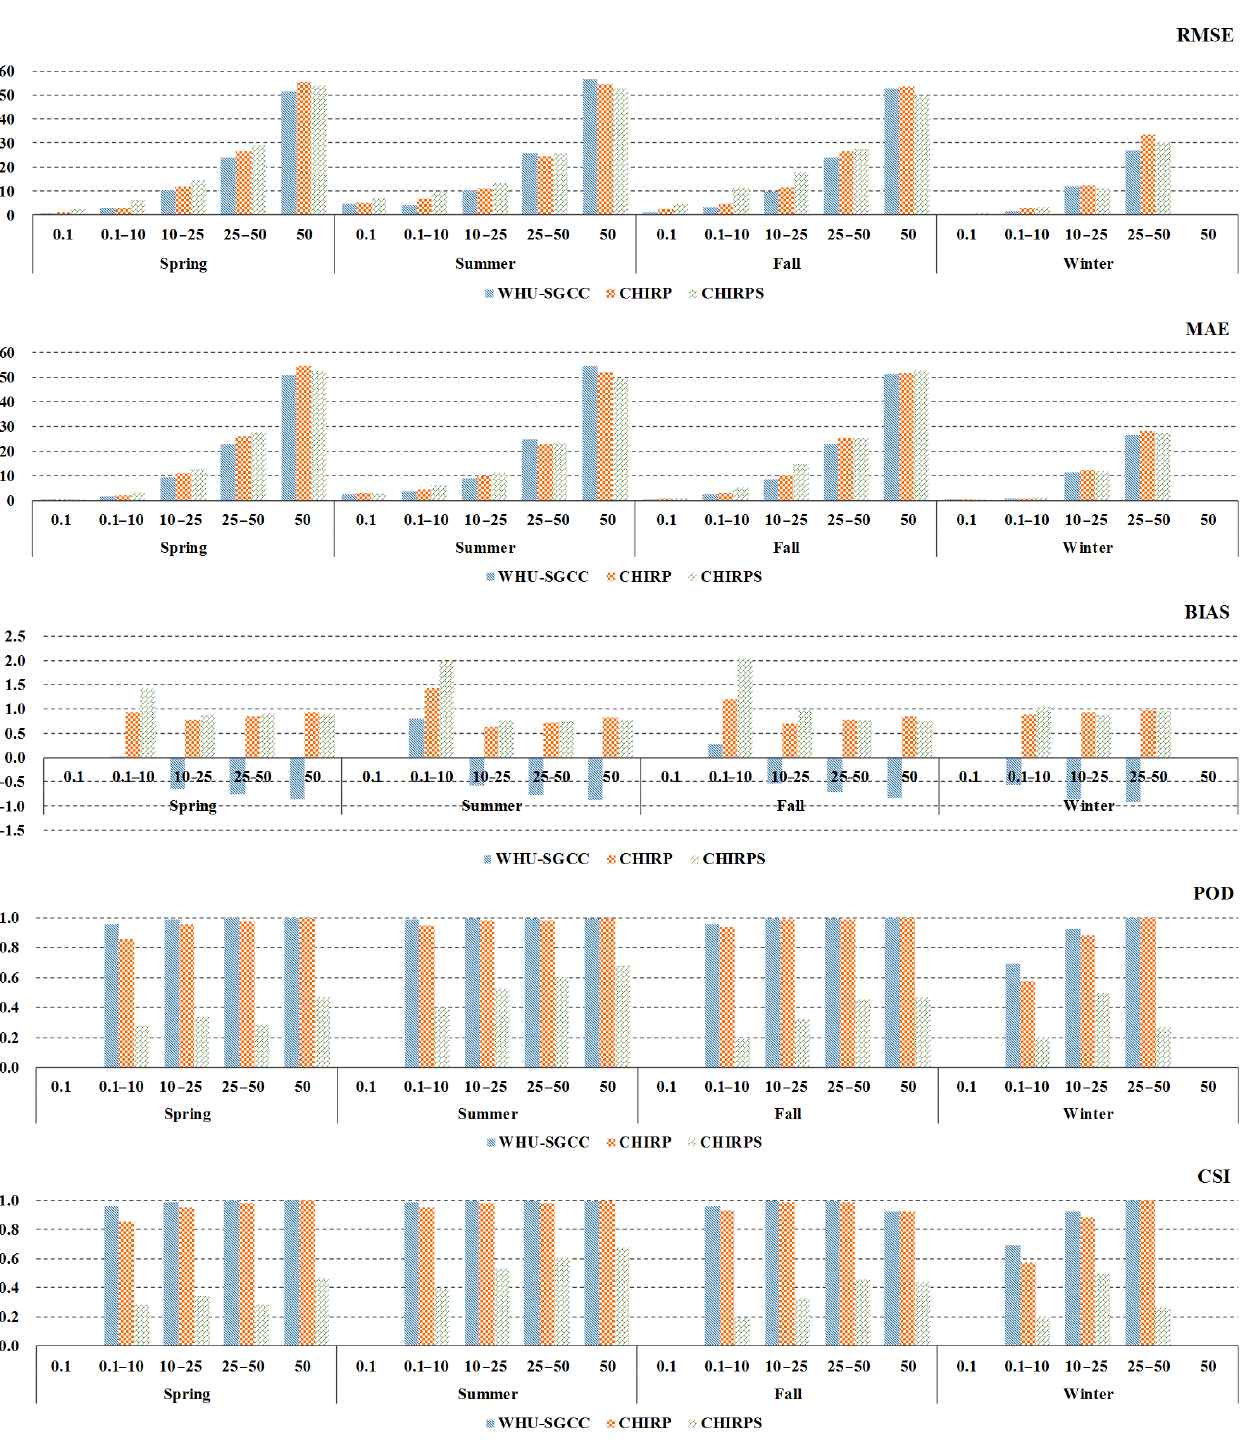
Figure 8. Accuracy assessment of liquid precipitation events from 1990 to